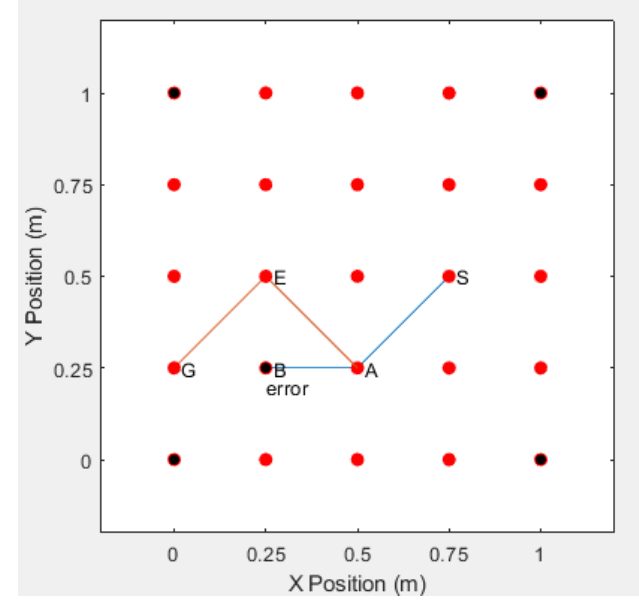
Figure 14. Simulation of Self-healing capability without